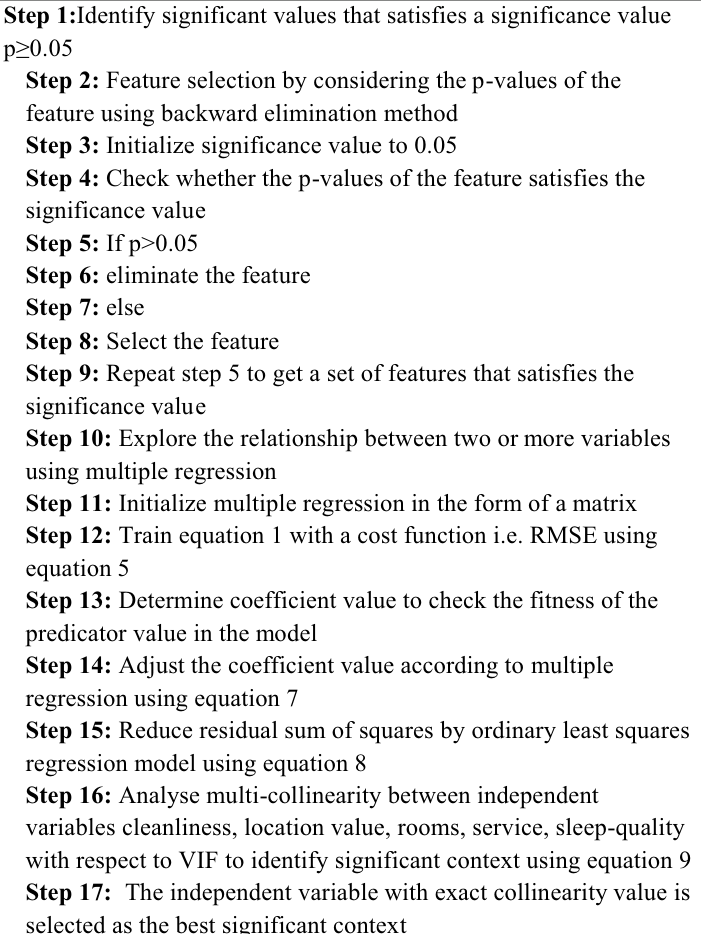
Algorithm 3: Multiple regression backward